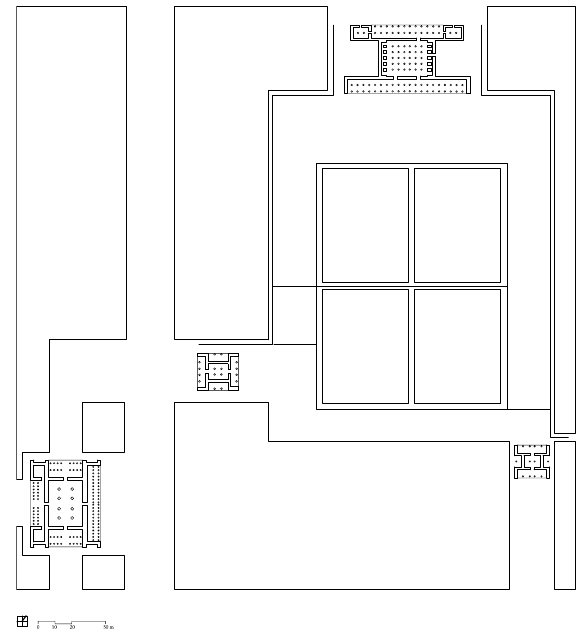
fig. 4. The plan of the royal City of Pasargadae. Source: reproduced by the author after